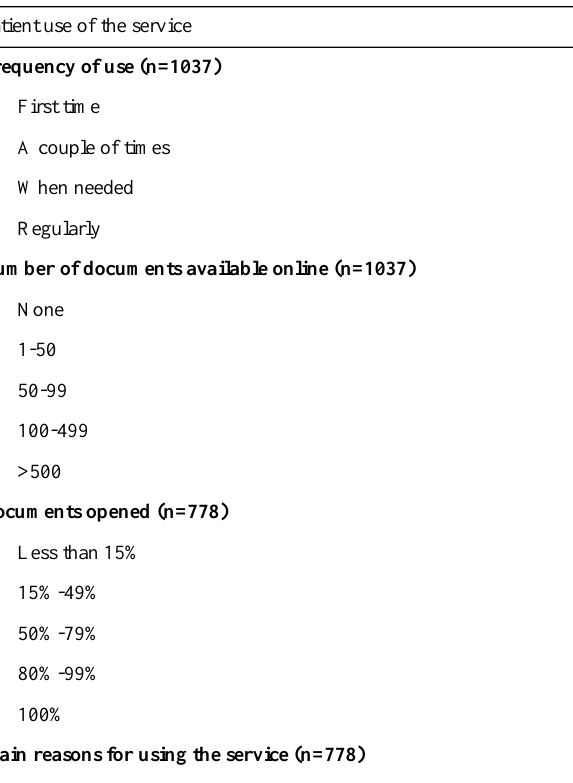
Table 2. Patient use of online access to electronic health